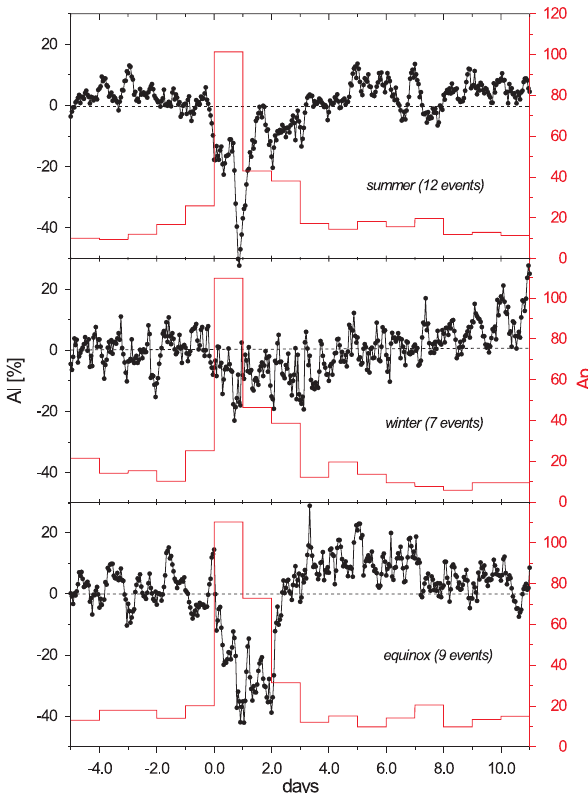
Fig. 17. Mean variation of the hourly AI values (black) and of the daily geomagnetic Ap values (red) derived from 28 individual iono- spheric storms with maximum Ap values ≥ 80 during the time in- terval from 1996 until 2008 separated for three seasons (summer, winter, equinox) by superimposed epoch